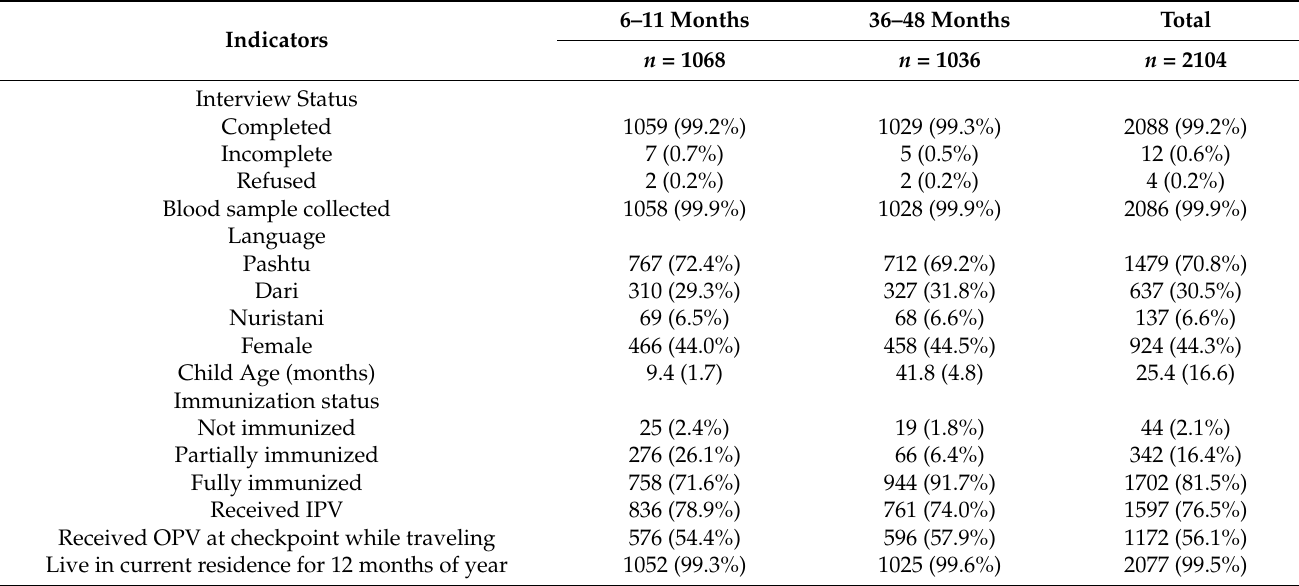
Table 3. Baseline characteristics of the study